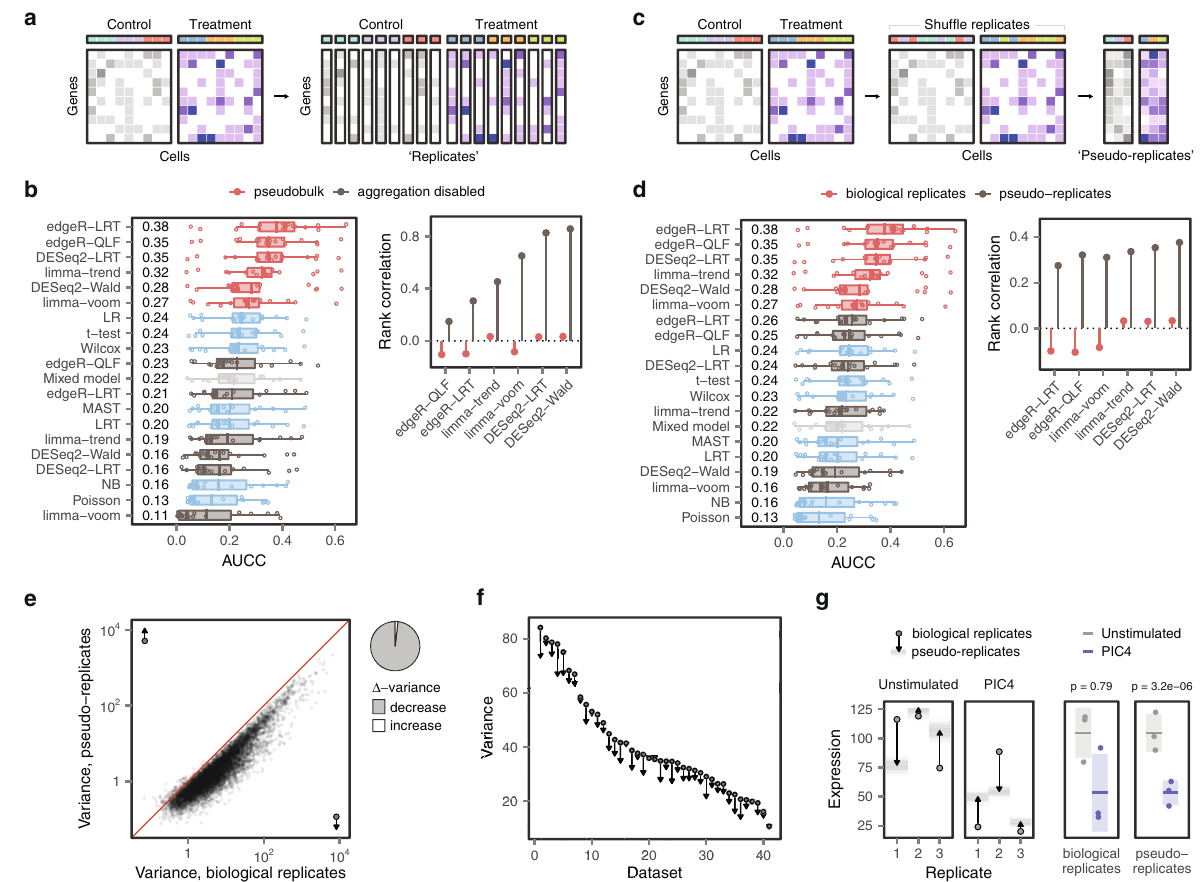
Fig. 3 DE analysis of single-cell data must account for biological replicates. a Schematic illustration of the experiment shown in b , in which the aggregation procedure was disabled and pseudobulk DE methods were applied to individual cells. b Left, AUCC of the original fourteen DE methods, plus six pseudobulk methods applied to individual cells, in the eighteen ground-truth datasets. Right, Spearman correlation between ERCC mean expression and – log 10 p-value assigned by six pseudobulk DE methods, before and after disabling the aggregation procedure. c Schematic illustration of the experiment shown in d , in which the replicate associated with each cell was shuf fl ed to produce ‘ pseudo-replicates. ’ d Left, AUCC of the original fourteen DE methods, plus six pseudobulk methods applied to pseudo-replicates, in the eighteen ground-truth datasets. Right, Spearman correlation between ERCC mean expression and – log 10 p-value assigned by six pseudobulk DE methods, before and after shuf fl ing replicates to produce pseudo-replicates. e Variance of gene expression in pseudobulks formed from biological replicates and pseudo-replicates in mouse bone marrow mononuclear cells stimulated with poly- I:C. Shuf fl ing the replicate associated with each cell produced a systematic decrease in the variance of gene expression. Right, pie chart shows the proportion of genes with increased or decreased variance in pseudo-replicates, as compared to biological replicates. f Decreases in the variance of gene expression in pseudo-replicates as compared to biological replicates across 46 scRNA-seq datasets. Points show the mean variance in biological replicates; arrowheads show the mean variance in pseudo-replicates. g Left, expression of the gene c in biological replicates (points) and pseudo-replicates (arrowheads) from unstimulated cells and cells stimulated with poly-I:C, with the range of possible pseudo-replicate expression values shown as a density. Right, mean (horizontal line) and variance (shaded area) of Txnrd3 expression in biological replicates (left) and pseudo-replicates (right). P-values were calculated by